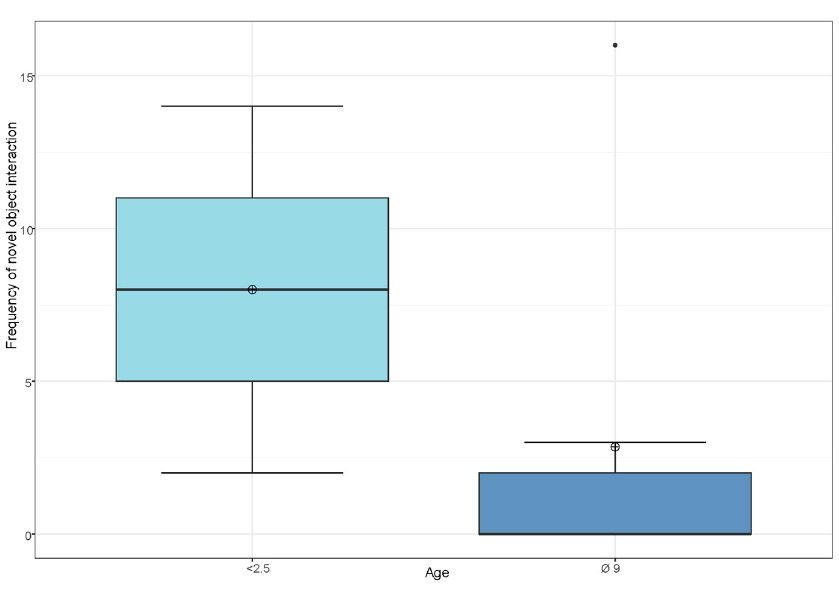
Figure 6. Influence of age on frequency of novel object interaction. The dot symbol indicates the outliers.